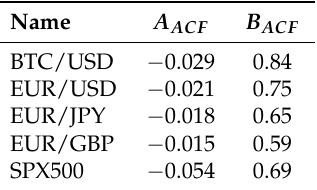
Figure 14. Autocorrelation function (ACF) of the number of directional changes per a bin in Θ -time. Vertical dashed line labels one week interval. There are 1008 bins in a week. Table 3. Parameters of the logarithmic decay y = A ACF log x + B ACF used to fit the autocorrelation function (ACF) of the number of directional changes in Θ -time (Figure